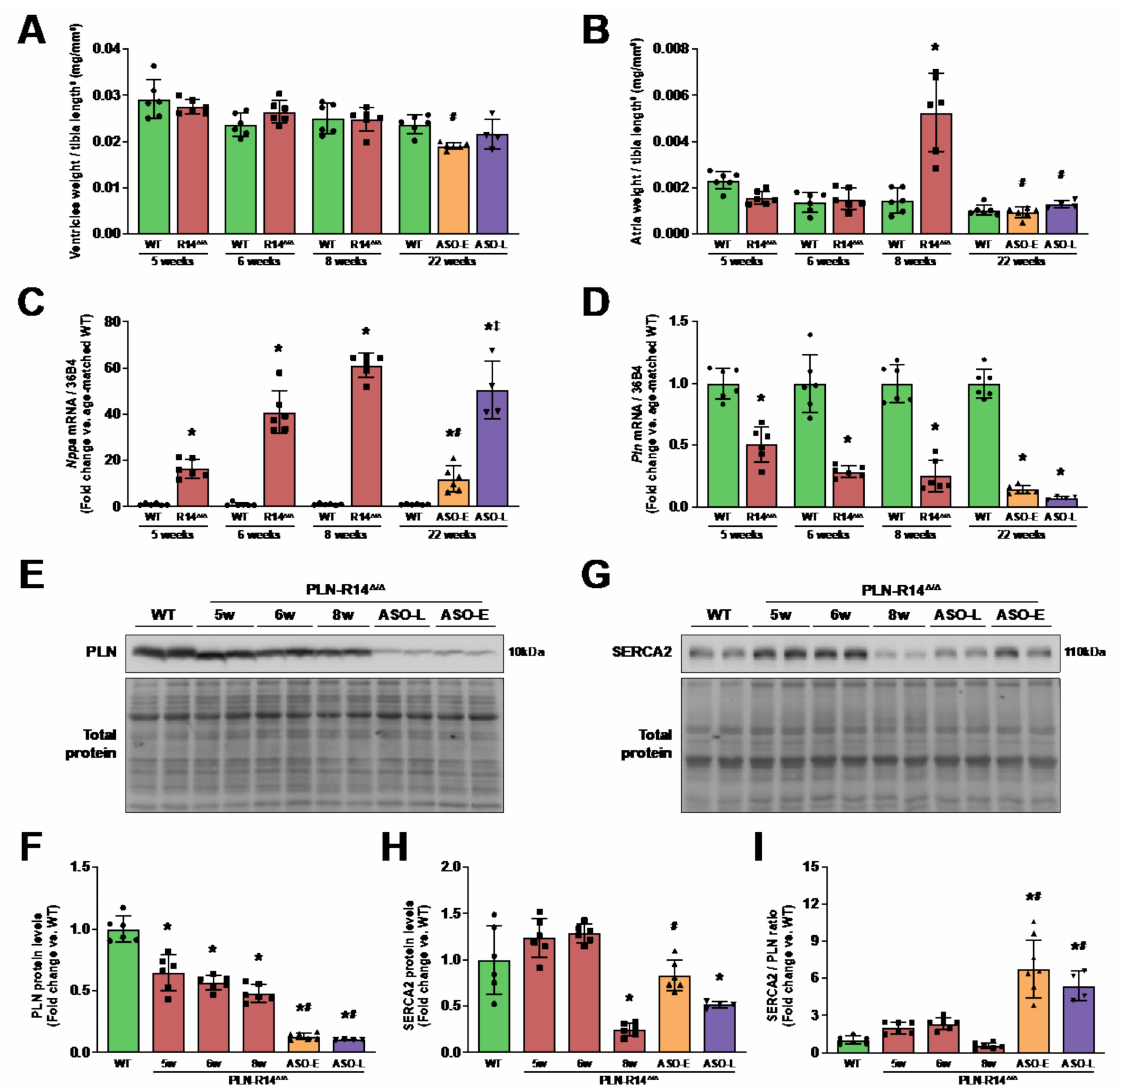
Figure 3. Congestive heart failure was inhibited by knockdown of PLN. ( A , B ) Biventricular ( A ) and atrial ( B ) weights of WT mice and vehicle-treated or early or late ASO-treated PLN-R14 ∆ / ∆ mice sacri- ficed at the age of 5, 6, 8 or 22 weeks, normalized for tibia length to the power 3. ( C , D ) Left-ventricular mRNA levels of Nppa (natriuretic peptide A; ANP) ( C ) and Pln (phospholamban; PLN) ( D ) nor- malized to housekeeping gene Rplp0 (ribosomal protein, large, P0; 36B4) mRNA levels in WT mice and vehicle-treated or early or late ASO-treated PLN-R14 ∆ / ∆ mice at the age of 5, 6, 8 or 22 weeks, shown as (log2) fold change compared to age-matched WT mice. ( E ) Left-ventricular PLN protein (upper panel) and total protein levels (lower panel) in WT mice and vehicle-treated or early or late ASO-treated PLN-R14 ∆ / ∆ mice at the age of 5, 6, 8 or 22 weeks. ( F ) PLN protein levels are normalized to total protein levels and quantified as fold change compared to WT mice. ( G ) Left-ventricular SERCA2 protein (upper panel) and total protein levels (lower panel) in WT mice and vehicle-treated or early or late ASO-treated PLN-R14 ∆ / ∆ mice at the age of 5, 6, 8 or 22 weeks. ( H ) SERCA2 pro- tein levels are normalized to total protein levels and quantified as fold change compared to WT mice. ( I ) Ratio of SERCA2 over PLN protein levels, presented as fold change compared to WT mice. n = 6 per group, except n = 4 for PLN-R14 ∆ / ∆ + ASO-late. Full blot images are shown in Figures S4 and S5. Data are shown as mean ± SD. * p < 0.05 vs. (age-matched) WT mice, # p < 0.05 vs. 8-week-old PLN-R14 ∆ / ∆ + vehicle , ‡ p < 0.05 vs. PLN-R14 ∆ / ∆ + ASO-early (two-way ANOVA followed by Tukey’s post hoc